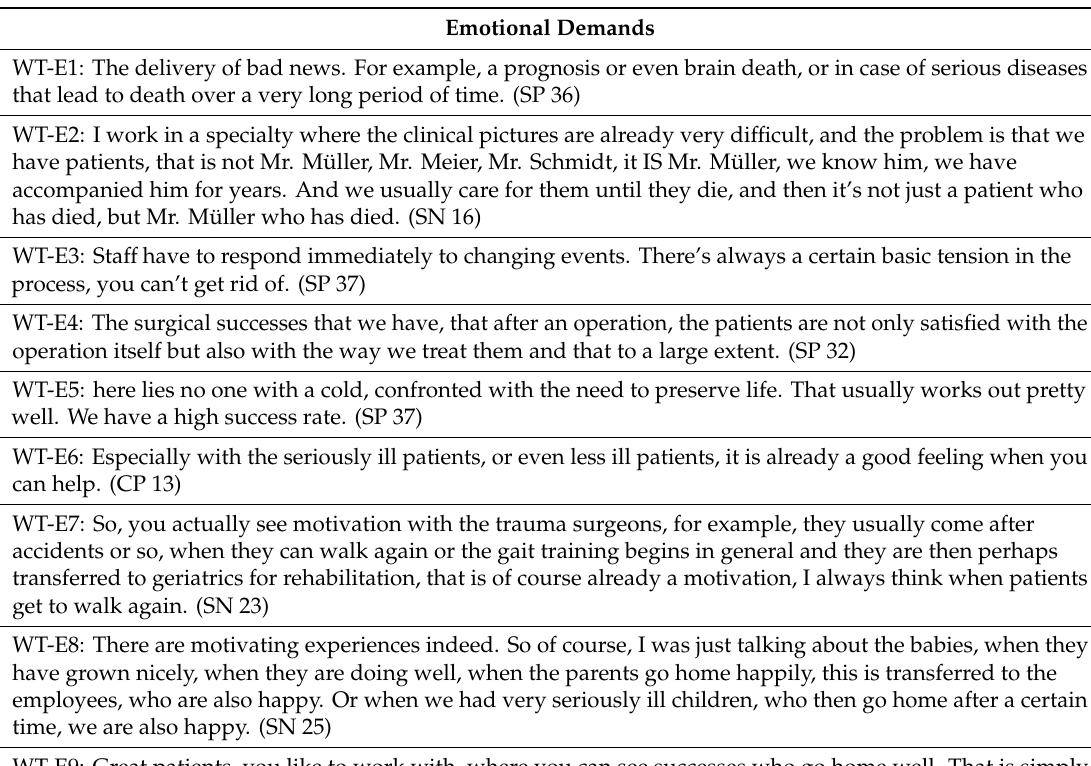
Table A4. Selected quotes of the participants related to the work